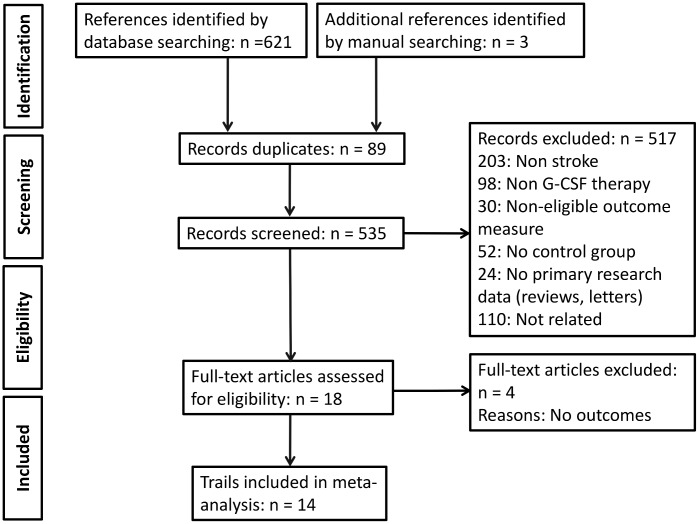
Study flow diagram.